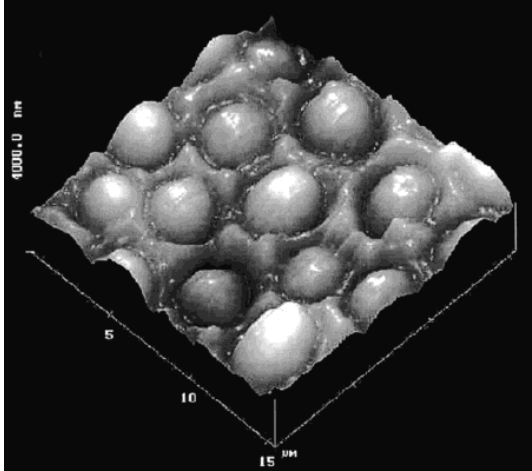
Figure 2. AFM image of a Saccharomyces cerevisiae cell imprinted sensor surface (reproduced with permission from [15]).